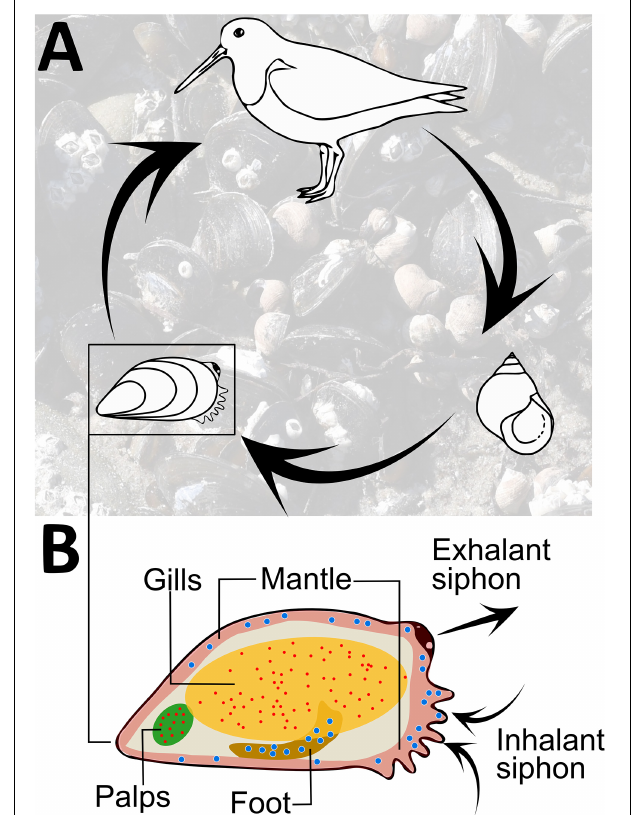
FIGURE 1 | (A) Schematic life cycle of the trematode species Himasthla elongata and Renicola roscovita that utilize seabirds as final hosts, and periwinkle snails Littorina littorea and blue mussels Mytilus edulis as first and second intermediate hosts, respectively. Background photo: M. edulis and L. littorea in a mussel bed during low tide. (B) Schematic drawing of the tissues of M. edulis that metacercariae of H. elongata (large blue dots) and R. roscovita (small red dots) typically parasitize; arrows indicate water flow during the mussel’s filtration activity. All organisms not drawn to scale.